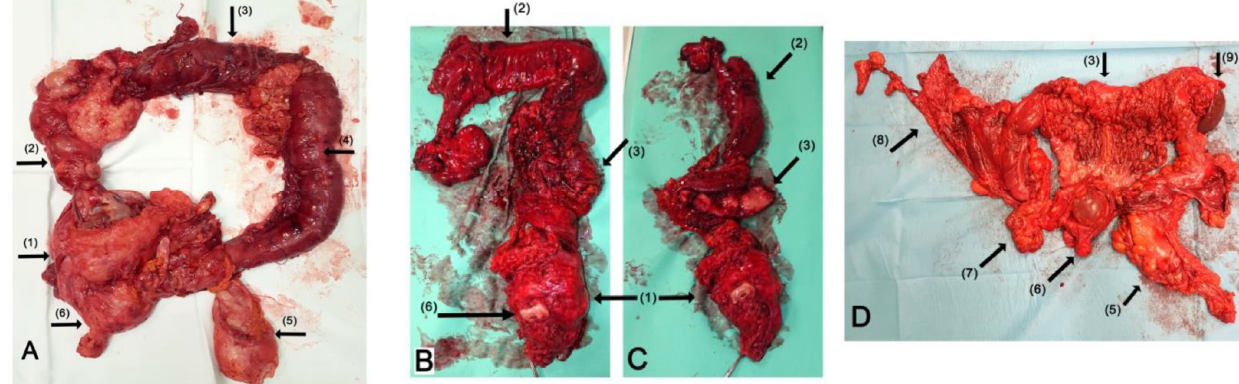
Figure 1. TC during debulking surgery for advanced OC. The photography of en bloc resected surgical specimen of TC: ( A ) the specimen after primary debulking surgery due to mucinous OC; ( B , C ) the specimen after interval debulking surgery due to serous OC; ( C ) the reverse view of transverse colon and “omental cake”; ( D ) the specimen after primary debulking surgery due to high-grade serous carcinoma. Arrows: (1) the ovarian tumor with uterus and pelvic peritoneum; (2) ascending colon; (3) transverse colon; (4) descending colon; (5) rectum; (6) uterine cervix; (7) distal ileum; (8) distal ileum; diaphragmatic and parietal peritoneum; (9) spleen.